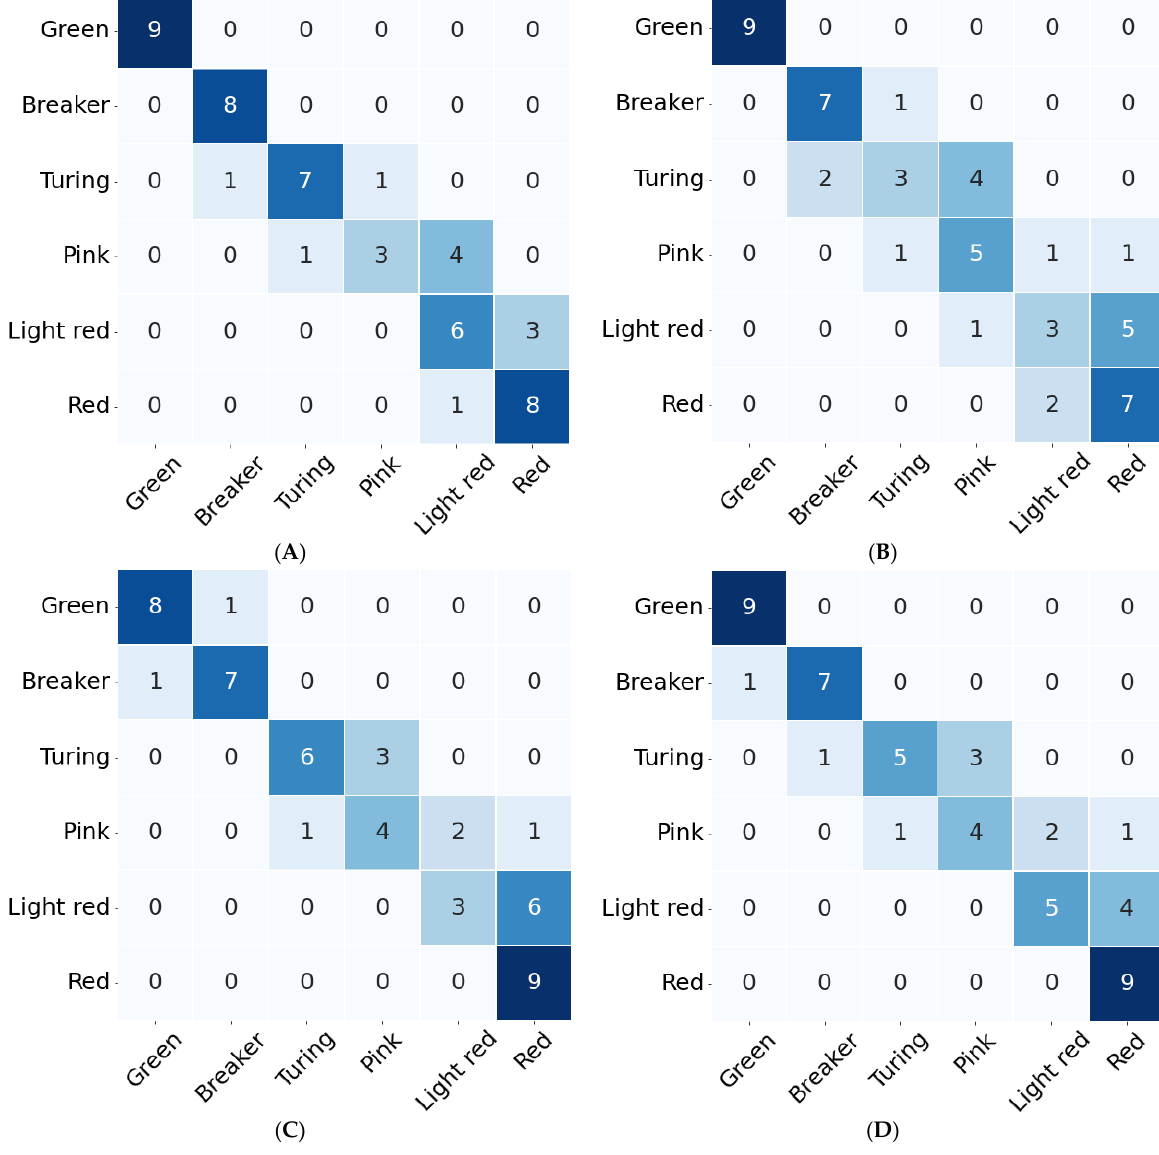
Figure 7. The confusion matrices of test set with VIS data ( A ), Red-NIR data ( B ), combination data of VIS and Red-NIR ( C ), and selected data from VIS and Red-NIR data ( D ). Table 4. The results of grid search and performance evaluation for SVC with input